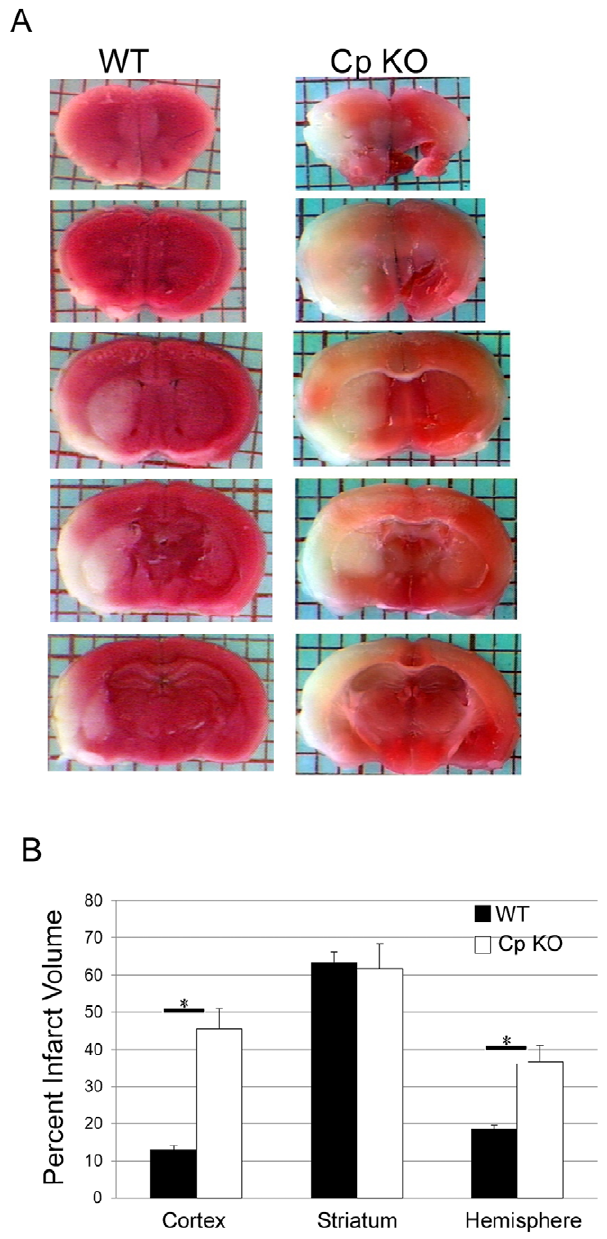
Figure 4. CpKO mice have increased cerebral infarct volume after focal ischemic stroke. A. Representative images of TTC-stained brain sections in mice subjected to 45 min MCAO with a 72 hours post-stroke survival. B. Calculation of percent infarct volume show a significant increase in the cortex and hemisphere of the CpKO mice compared to WT mice. (*p , 0.002; n=8 WT and 6 KO